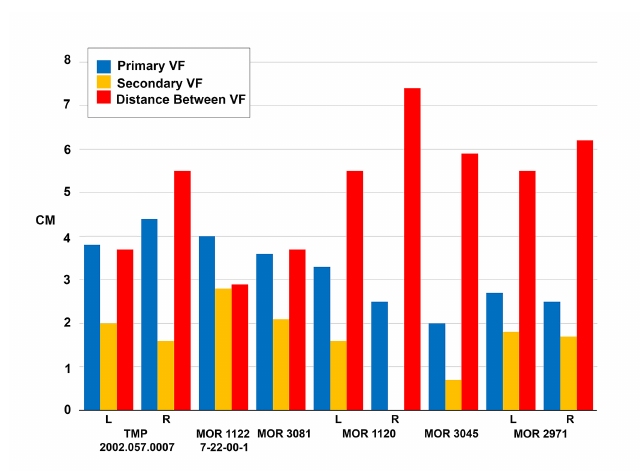
Figure 11. Graphical representation of ventromedial fo - ramina measurement data presented in Table 2. VF, ventro- medial foramina. Composed using Microsoft Excel.